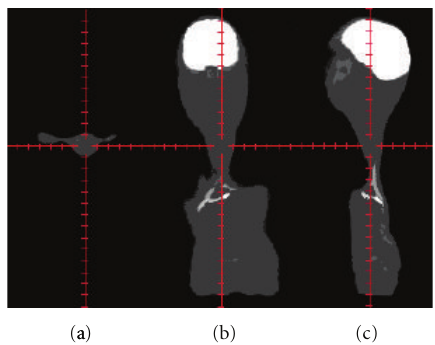
Figure 1: An example of how the standard MC-LDDMM algorithm fails for full body mapping. (a) axial, (b) coronal, and (c) sagittal images of a deformed adult template. Notice that the abdominal organs have been catastrophically shrunk causing distortions in nearby neck and thoracic structures and that details in the face and skull have been lost.